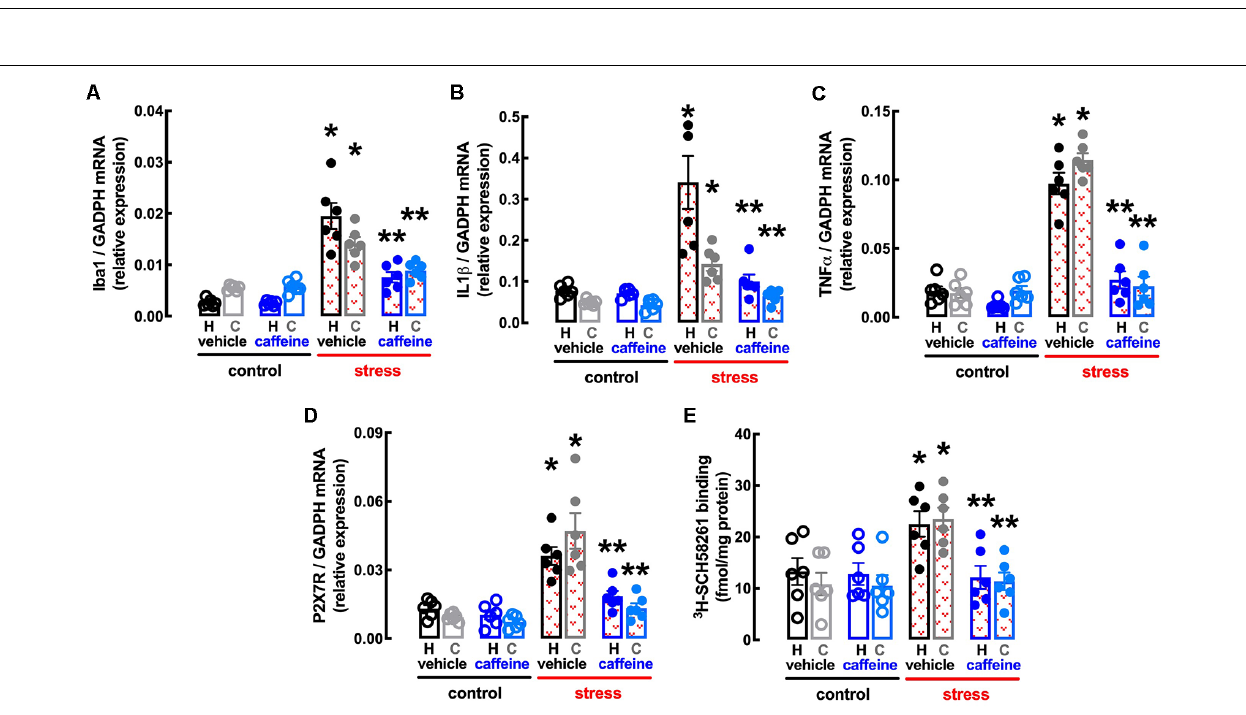
FIGURE 7 | Male adult Wistar rats (8–10 weeks old) subject to a protocol of restraint stress (4 h/day) during 14 days display an increased expression of inflammatory markers and an up-regulation of P 2X7 and of A 2A receptors in the hippocampus (black, dark blue) and prefrontal cortex (gray, light blue) which were prevented by the adenosine antagonist caffeine (caff). Whereas caffeine consumption (0.3 g/L, po, beginning 3 days before the stress protocol and until the sacrifice of the animals; blue) was devoid of effects in non-stressed control rats (open bars), caffeine prevented all alterations of stressed rats (red checkered bars), namely the increased expression of the microglia marker Iba1 (A) , of interleukin 1 β (IL1 β ; B ), of tumor necrosis factor α (TNF α ; C ) and P 2X7 receptors (P 2X7 R; D ) as well as an increased density of A 2A receptors (A 2A R; E ) as assessed by the binding density of a supramaximal concentration of the selective A 2A R antagonist 3 H-SCH58261 (2 nM). Data are shown as mean ± SEM; n = 5–7 rats per group. * P < 0.05 vs. control-water, ** P < 0.05 vs. stress-water using a Tukey’s multiple comparisons post hoc test after a two-way